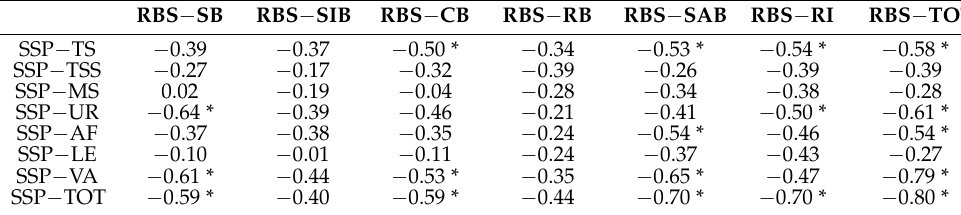
Table 4. Spearman correlation analysis between SSP and RBS-R subscales and total